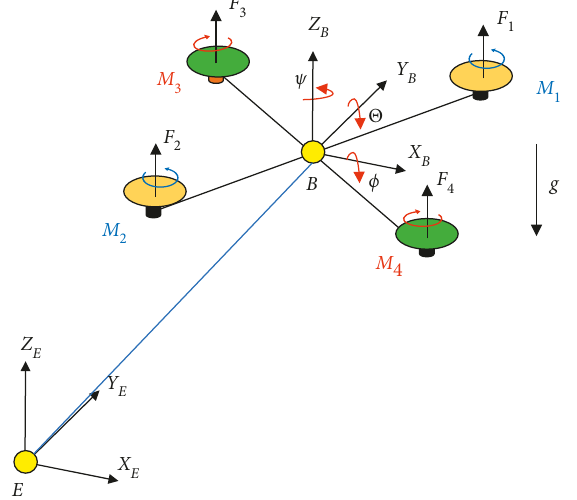
Figure 1: Representation of the quadrotor